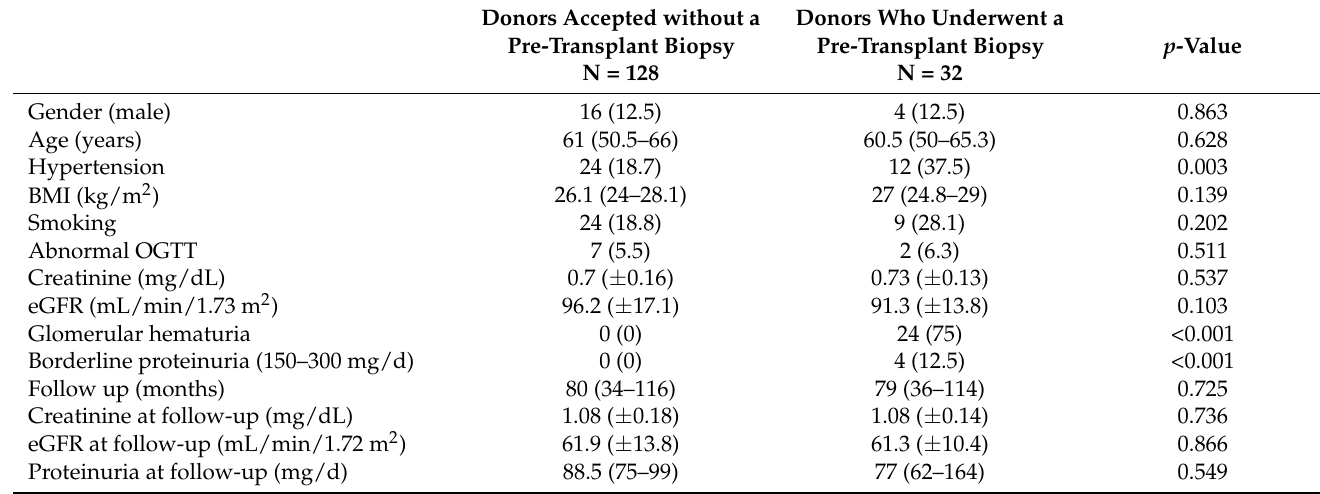
Table 3. Demographics, comorbidities and outcomes of living kidney donors who donated with and without a pre-transplant biopsy [N (%) or Mean ( ± SD) or Median